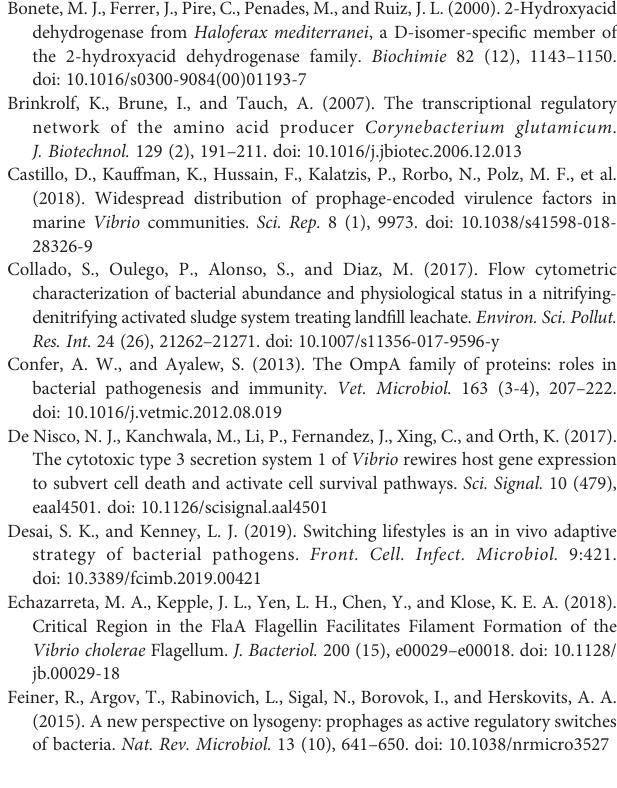
SUPPLEMENTARY FIGURE 2 | Activities of the malate dehydrogenase and citrate synthase encoded by the DEGs Vpachn25_RS01720